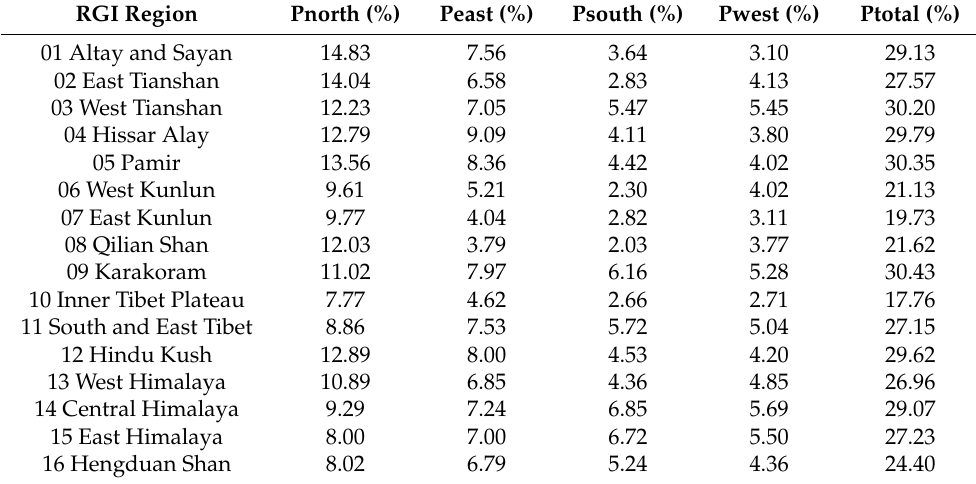
Table 2. Glacier shading area percentages in the regions within